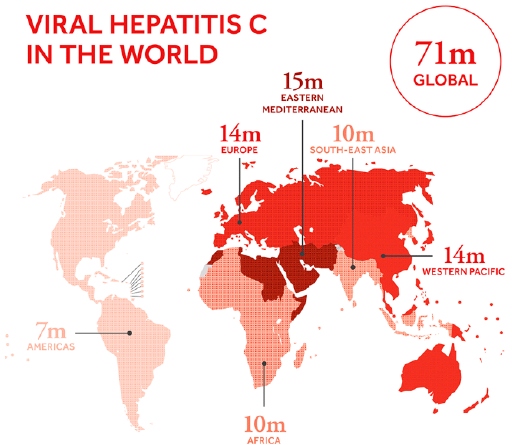
Figure 1. Viral hepatitis C in the world (adopted from the global hepatitis report, 2017. https://www.who.int/hepatitis/news-events/global-hepatitis-report2017-infographic/en/).